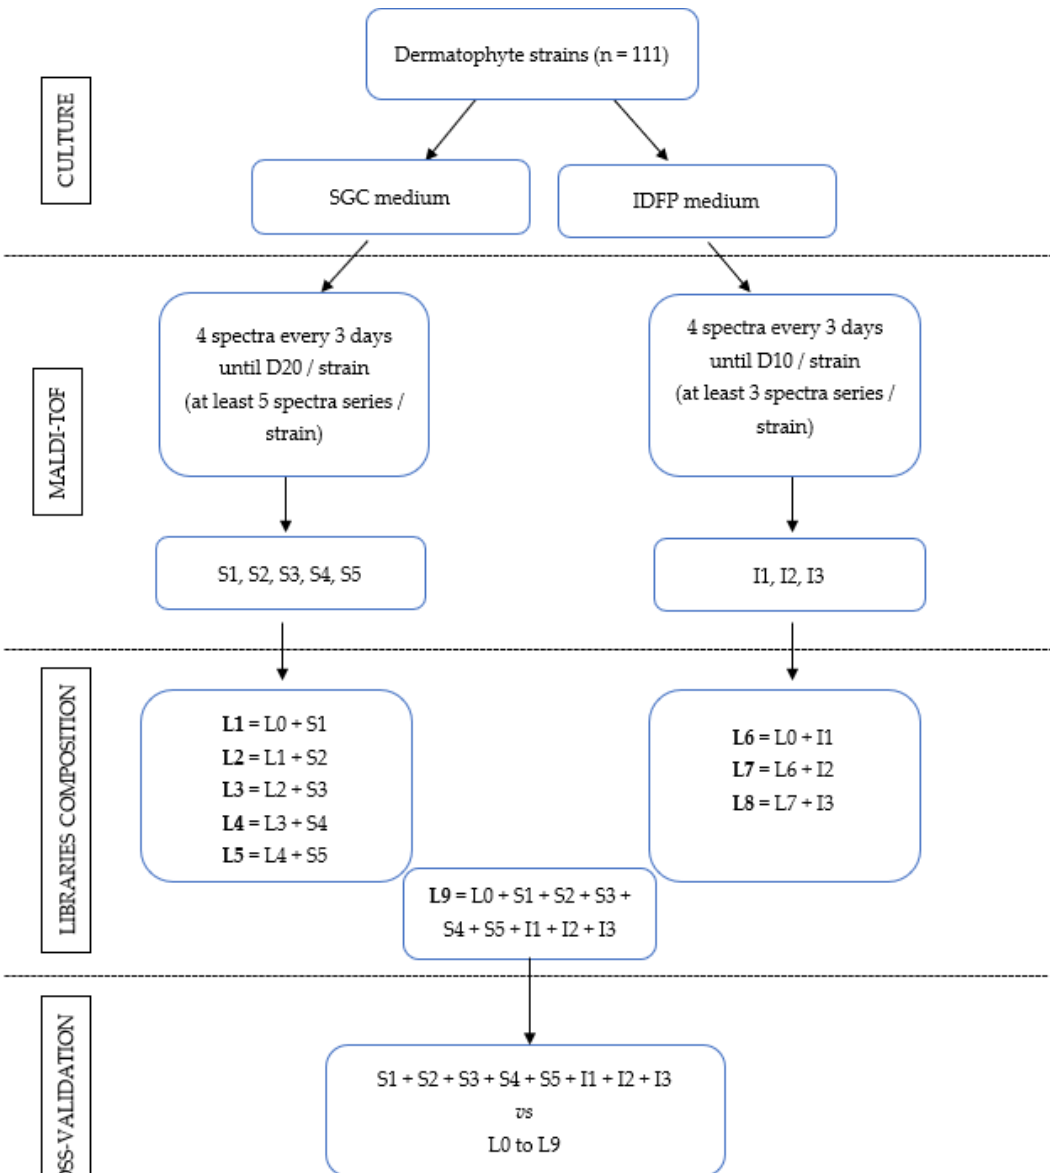
Figure 1. Overall design of the study. S1, S2, S3, S4 and S5 are files of spectra of increasing age acquired from cultures on Sabouraud medium plus gentamicin and chloramphenicol (SGC) medium. I1, I2 and I3 are files of spectra of increasing age acquired from cultures on ID-fungi plate (IDFP). L0 is constituted by spectra of BCCM/IHEM Fungi collection strains currently in MSI-2.